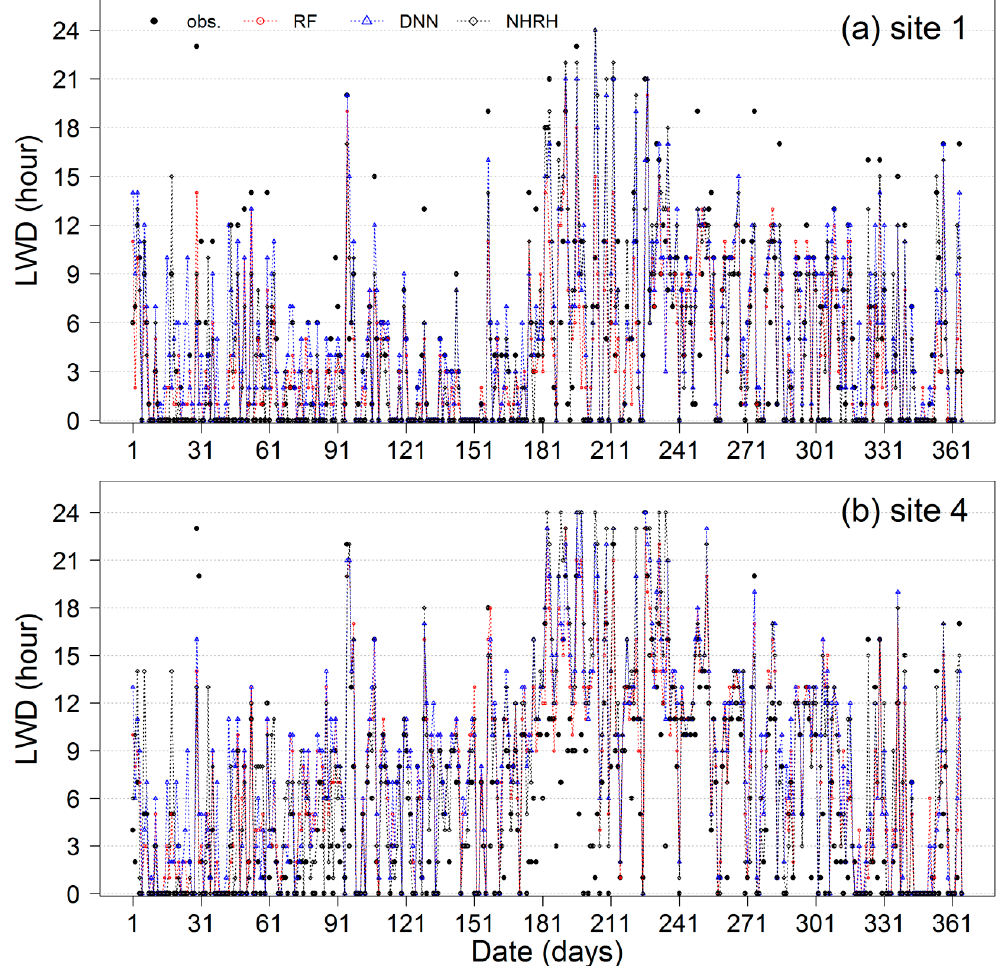
Figure 10. Time series plots of LWD observations and LWD predictions by the RF, DNN, and NHRH methods for sites 1 and 4 in 2017.